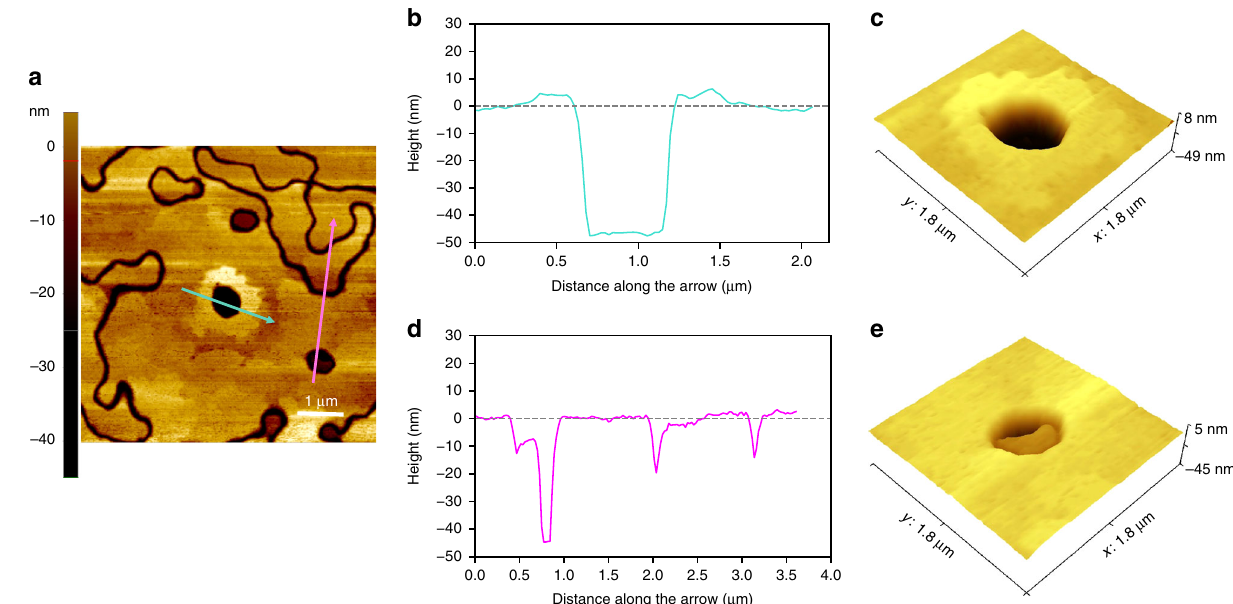
Fig. 1 Experimental observations of an annealed Ni fi lm on sapphire. a Atomic force microscopy (AFM) topography image of a Ni fi lm on sapphire after heat treatment, showing sunken grains with (turquoise arrow) and without (magenta arrow) an elevated ridge around the edges. b A linear topographic pro fi le across the hole indicated using a turquoise arrow in a showing a Ni ridge at the perimeter of the sunken grain. c 3-D image of the same hole showing an elevated ridge surrounding the sunken grain. d A linear topographic pro fi le across the hole indicated using the magenta arrow in a showing no measurable ridge formation. e 3-D image around the same hole showing a depression left by grain